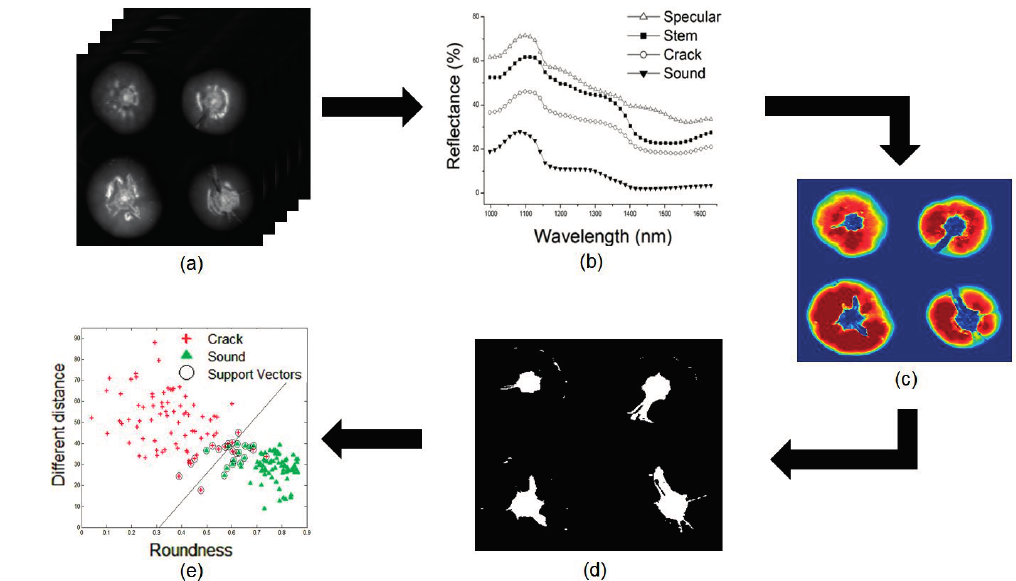
Figure 2. The procedure used to analyze cracked and sound tomatoes using hyperspectral NIR imaging. ( a ) Hyperspectral NIR imaging data were obtained. ( b ) Spectral analyses were then performed and a PLS-DA model was developed to detect cracks on the tomato. ( c ) A PLS-DA image, and ( d ) a PLS-DA binary image were obtained. ( e ) Finally, the data were classified using statistical